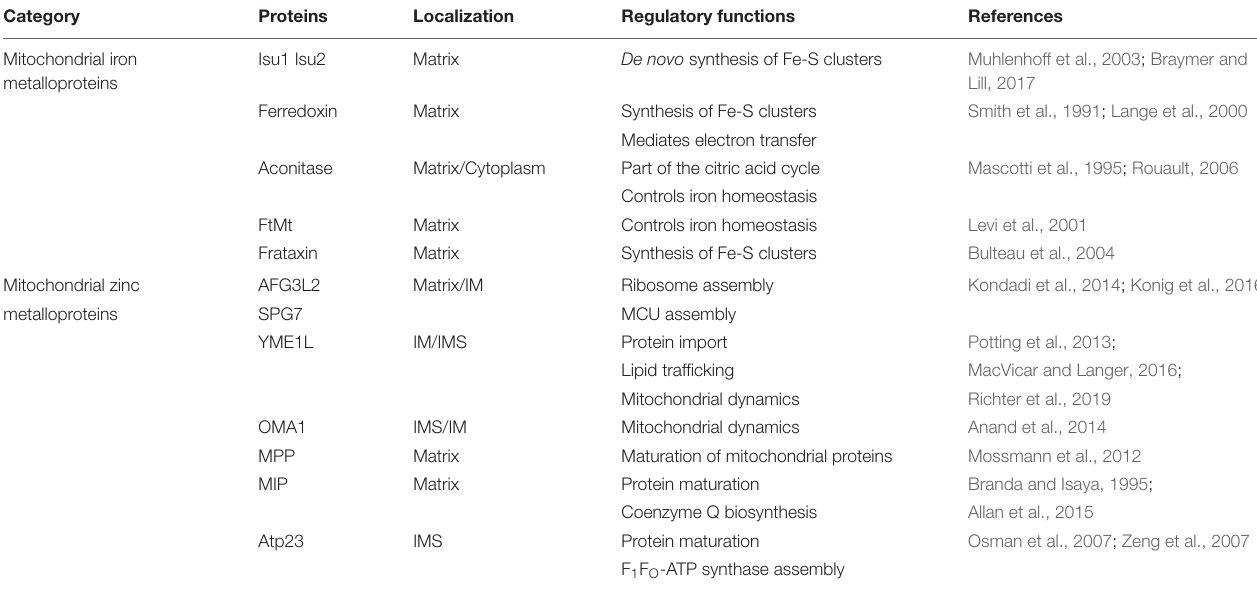
TABLE 1 | Mitochondrial metalloproteins and associated functions.